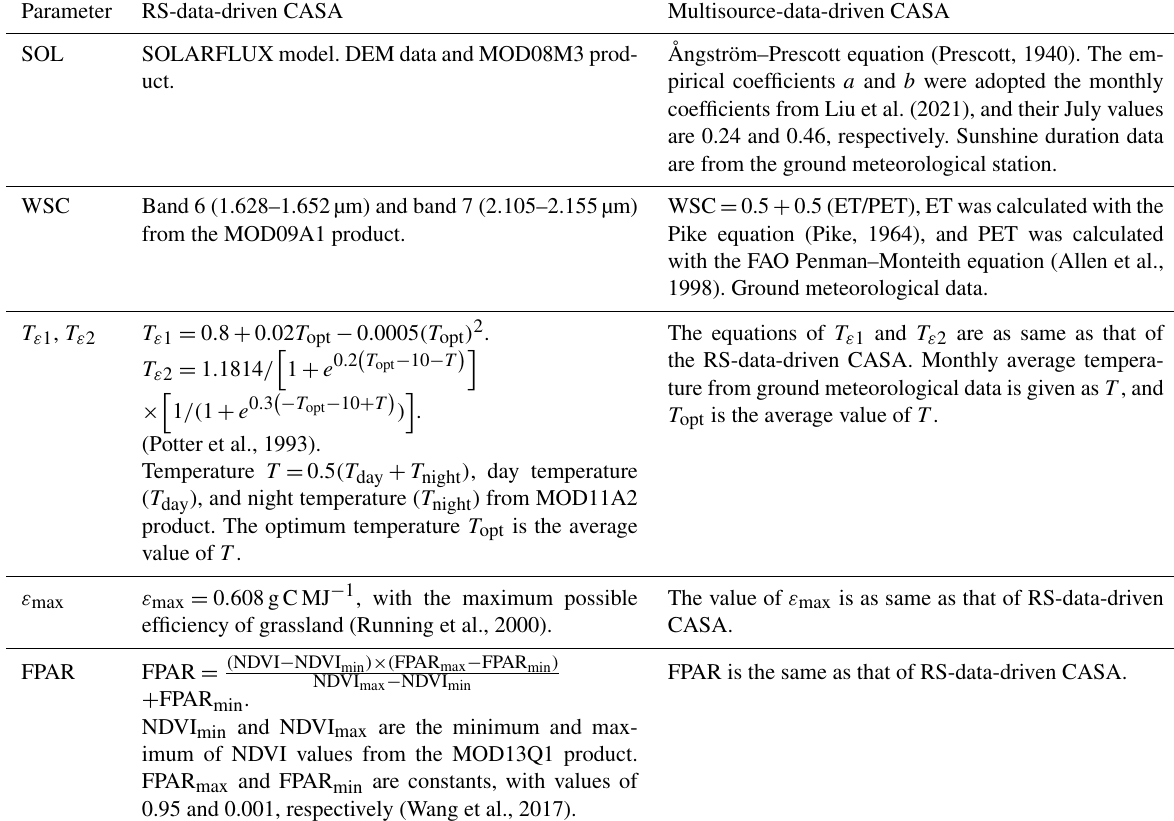
Table 1. Calculation method and input data for CASA model parameters. Parameter RS-data-driven